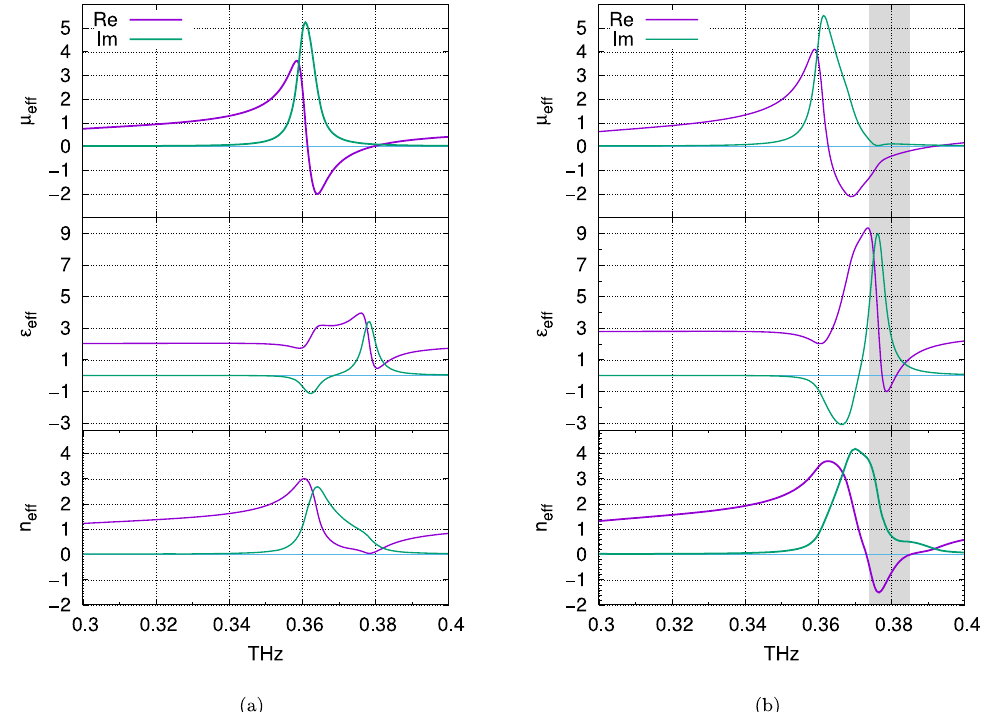
Fig. 9. Effect of spatial mode coupling: effective electromagnetic parameters (real and imaginary parts): permeability m eff (top), permittivity (cid:1) eff (middle) and effective index n eff (bottom). (a) Low mode coupling: lattice period l p =360 m m: the minimum value of the < 0.04; (b) strong mode coupling: lattice period l m m. The shaded area denotes the bandwidth effective refractive index is n eff p = 260 min of the negative effective index: the minimum value of the effective refractive index is n eff = (cid:1) 1.5. The static effective permittivity min values yielded by the Maxwell – Garnett formula, (cid:1) eff =2.1 and (cid:1) eff = 2.9, are in good agreement with the result of the simulation.